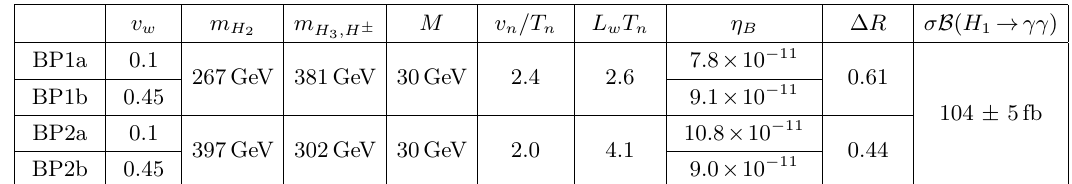
, m (= m ) and M are H 3 H ± 2